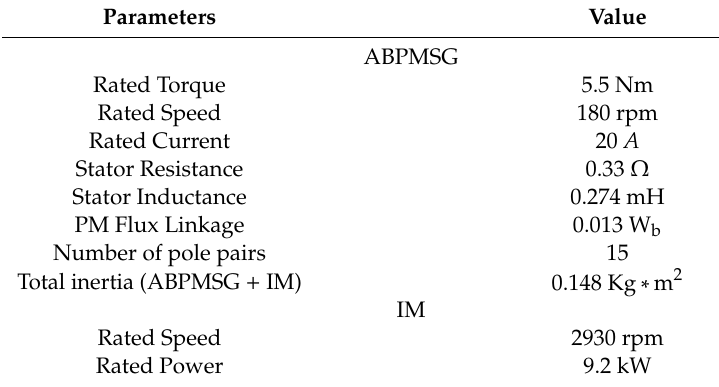
Figure 10. Experimental test rig. Table 5. Parameters of the experimental